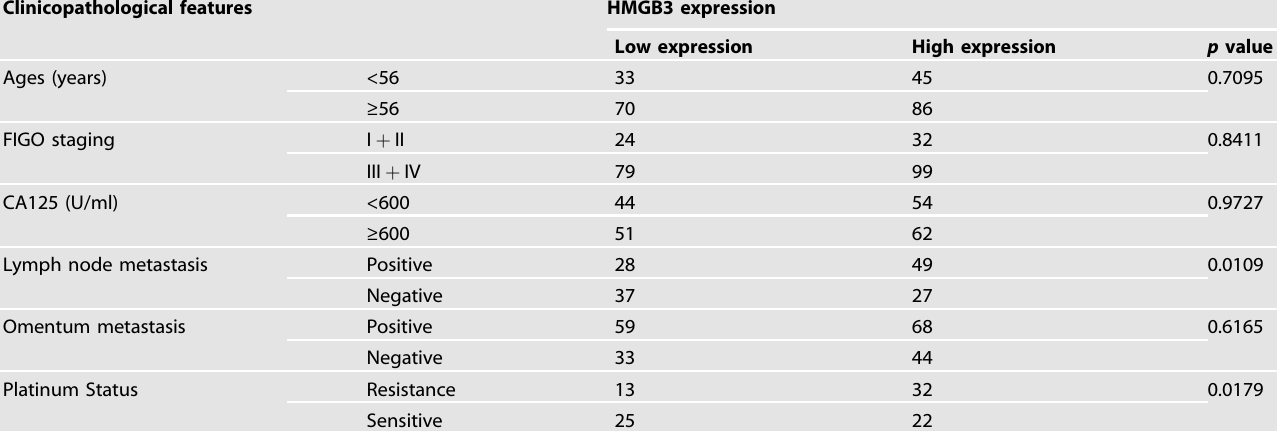
Table 1. Correlation between HMGB3 expression and clinicopathological